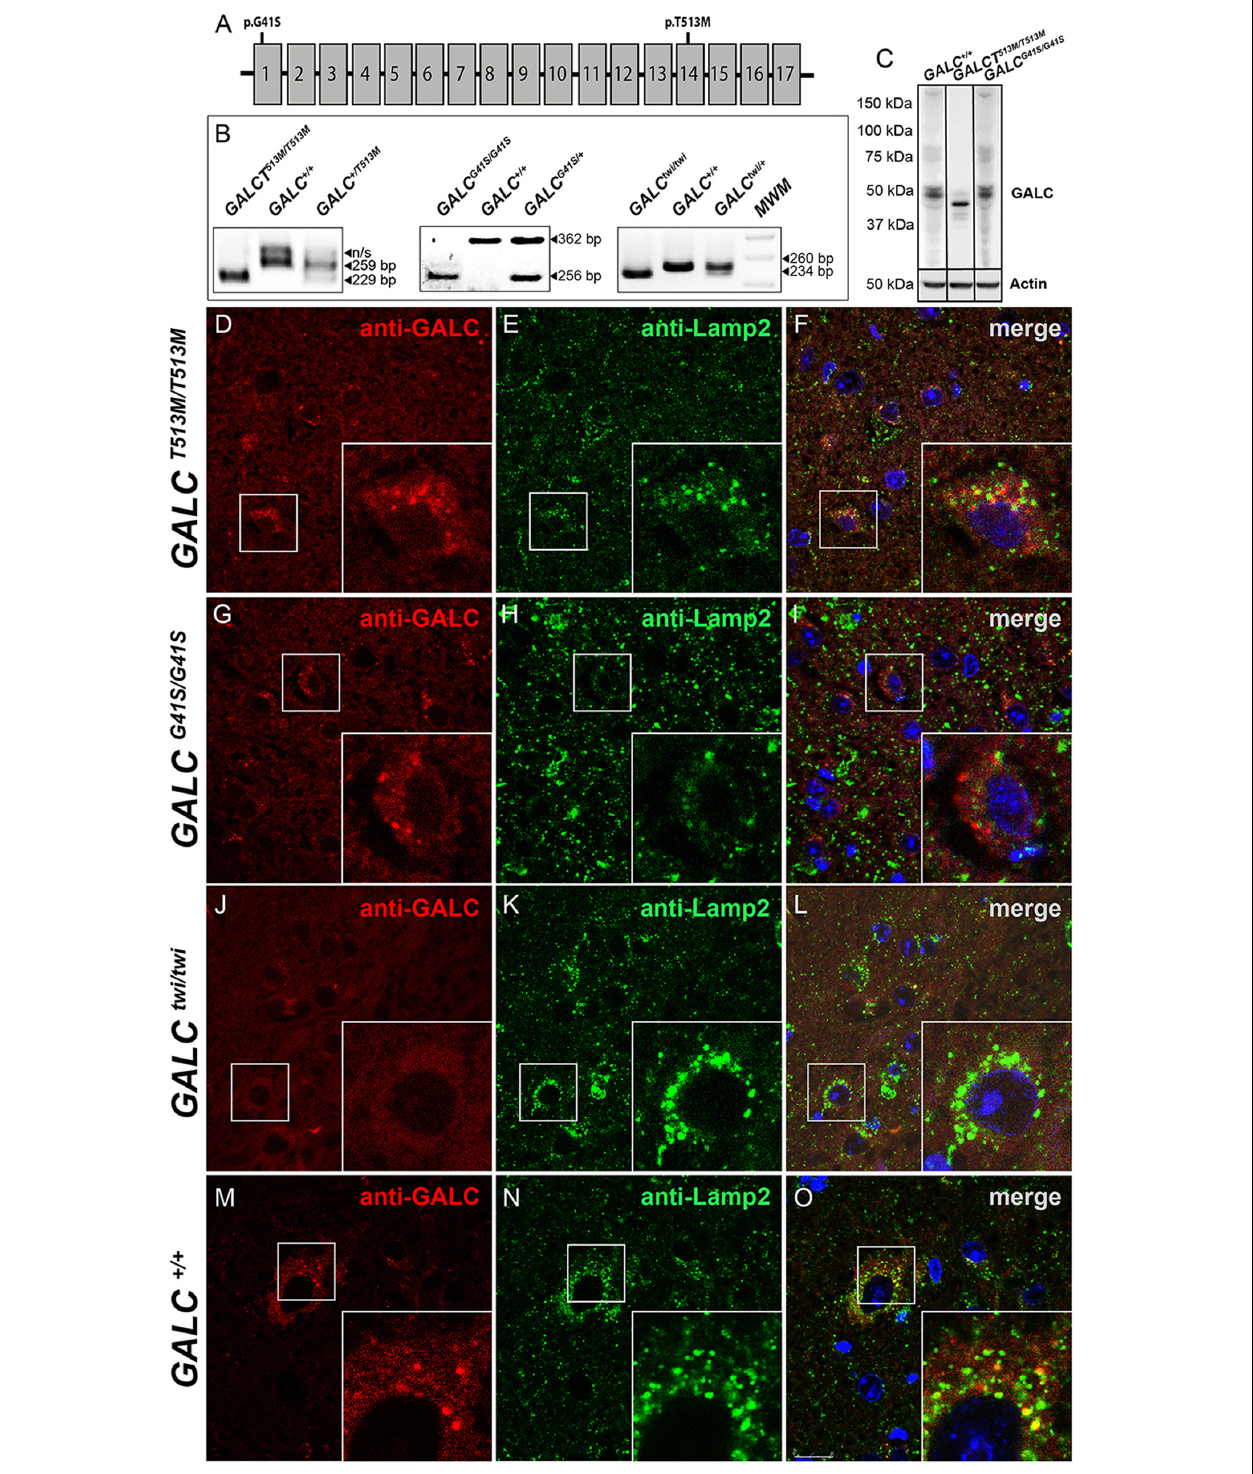
FIGURE 1 | Lysosomal localization of mutated GALC protein is reduced in GALC T 513 M / T 513 M and GALC G 41 S / G 41 S mice. (A) Localization of the G41S and T513M mutations within the GALC gene. (B) PCR-based identification of mutations in GALC T 513 M / T 513 M and GALC G 41 S / G 41 S . Mutation in GALC twi / twi and GALC + / + were used as references. (C) Western blot analysis of GALC protein lysates prepared from P40 brains. Actin was used for loading control. (D–O) Immunohistochemistry on cryosections of P25 brain tissue showing colocalization of GALC protein (red) with LAMP-2 (green) in lysosomes of GALC T 513 M / T 513 M , GALC G 41 S / G 41 S , GALC twi / twi , and GALC + / + mice. DAPI, blue. Scale bar = 50 µ m.